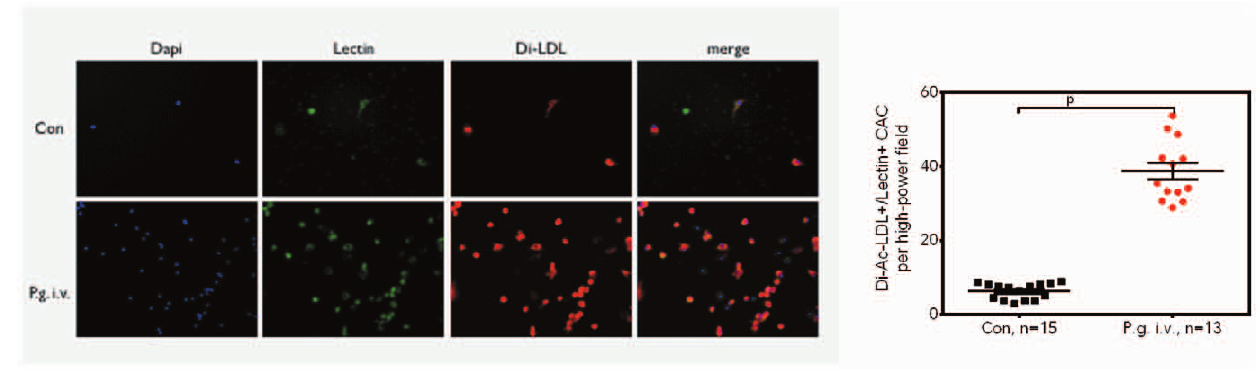
Figure 2. Bacteremia with P. gingivalis leads to increased numbers of circulating angiogenic cells (CACs) in wildtype mice. Strongly increased counts of Dil-Ac-LDL + /Lectin + spleen-derived CACs in P. gingivalis infected mice. Data are presented as means of five high-power fields/ mouse 6 SEM, statistical testing was performed using paired t-tests to account for day-to-day staining variability.